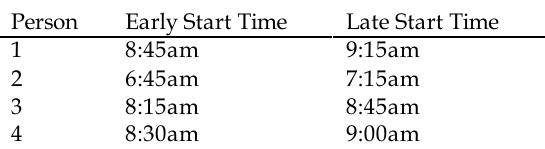
Table 2. Start Times of Mandatory Activities